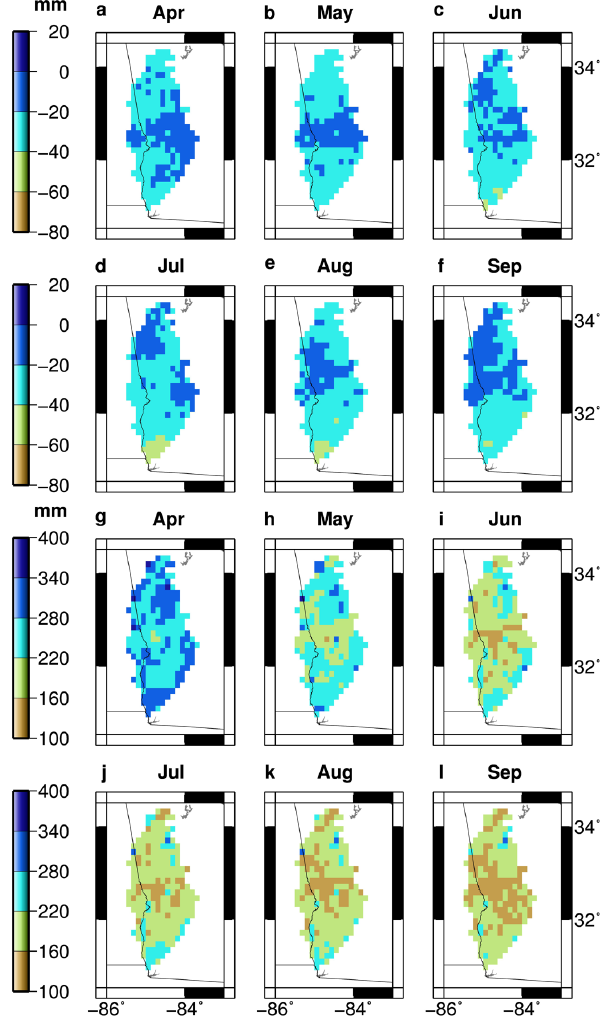
Fig. 8. VIC-model estimated average monthly soil moisture: (a) to (f) forecasted anomalies (at 1-month lead) estimated by subtracting total soil moisture during La Ni˜na years from soil moisture clima- tology for the period 1981 to 2010, which is shown in panels (g) to (l)